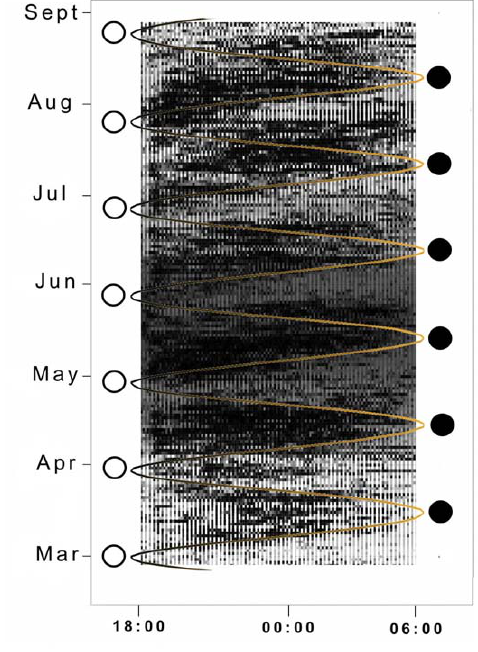
Figure 4. The nighttime activity patterns of 37 swallow-tailed gulls ( Creagrus furcatus ) during the breeding period from Espan ˜ ola Island, during the study period extending from March to September 2010. Each small square represents the mean proportion of time the sensors were wet during 10-minute blocks throughout each night of the study. Darker blocks indicate higher proportions of time wet and lighter blocks indicate small proportions of time wet. Curved line and circles represent the lunar cycle from full (black line, open circles) to new moon (yellow line, filled circles).